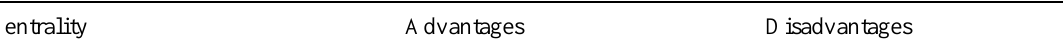
Reduced distribution of information (e.g., Shaw 1981) Possible perception as undemocratic and unfair Greater vulnerability to targeted attacks (Albert et al.